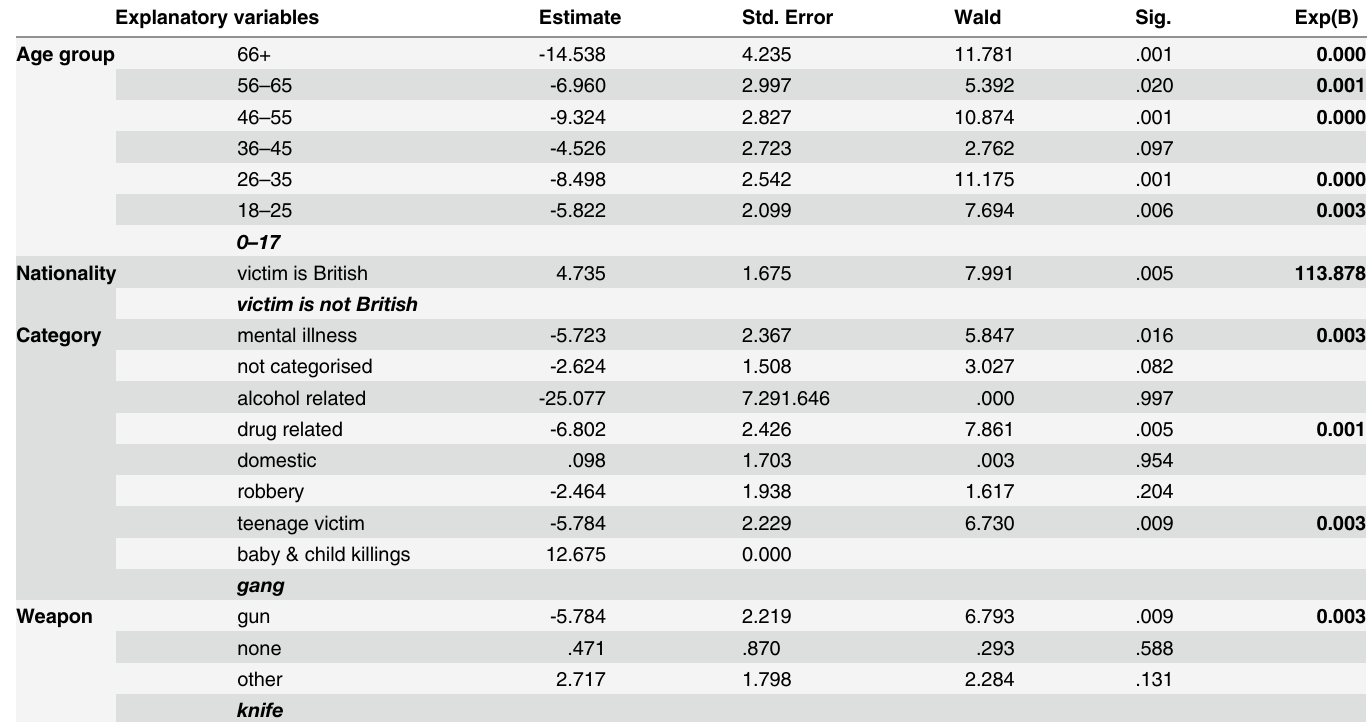
Table 1. Parameter estimates of the OLR model (only significant variables are